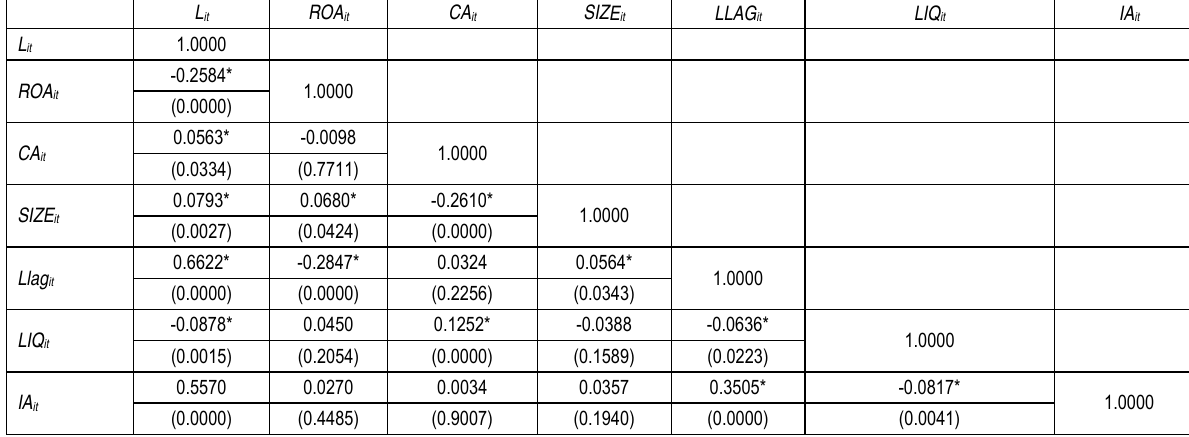
Table 14. Correlation matrix, Model